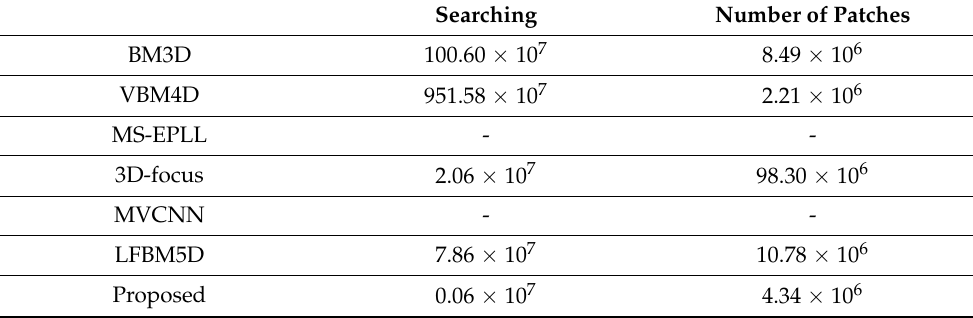
Table 8. Comparison of processing